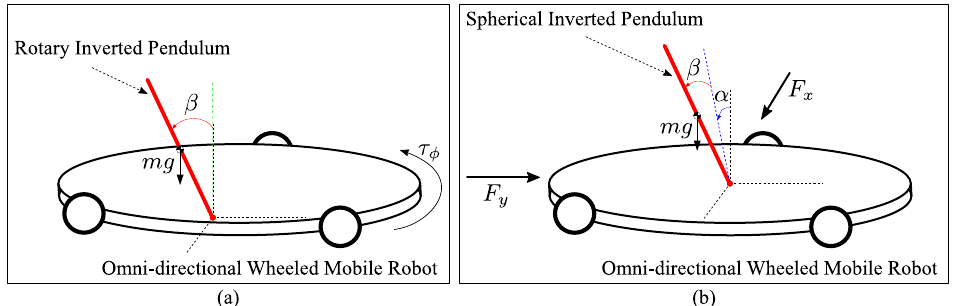
Figure 1. Schematic overview of the proposed systems: ( a ) is a rotary inverted pendulum, and ( b ) is a spherical inverted